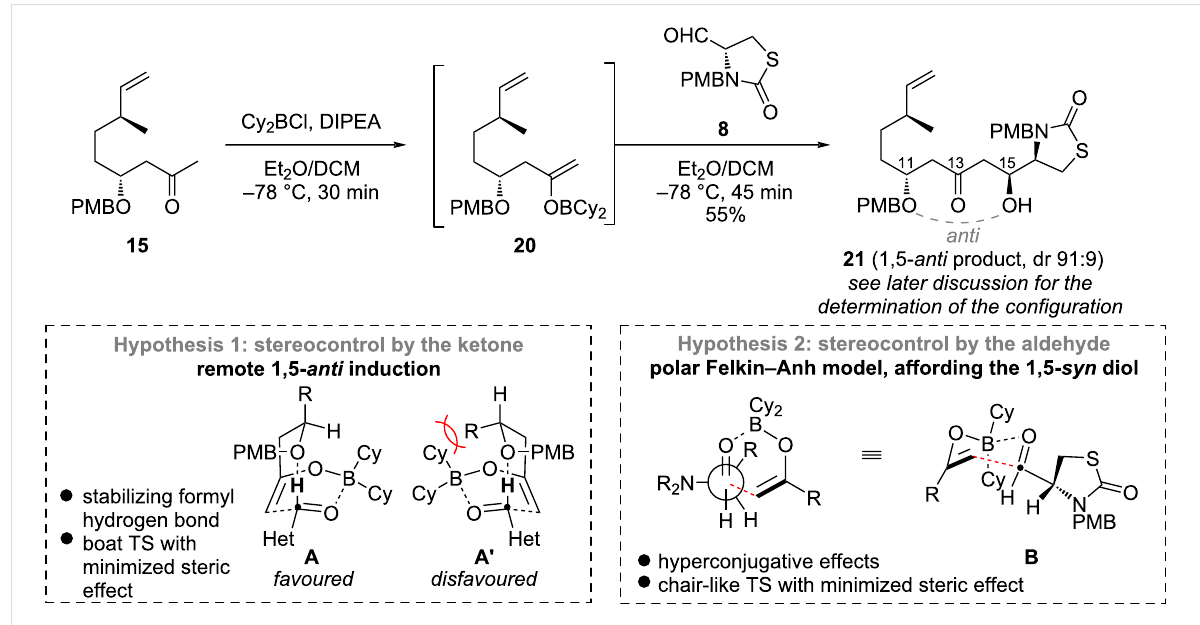
Scheme 3: Synthesis of fragment 21 through a stereoselective aldol